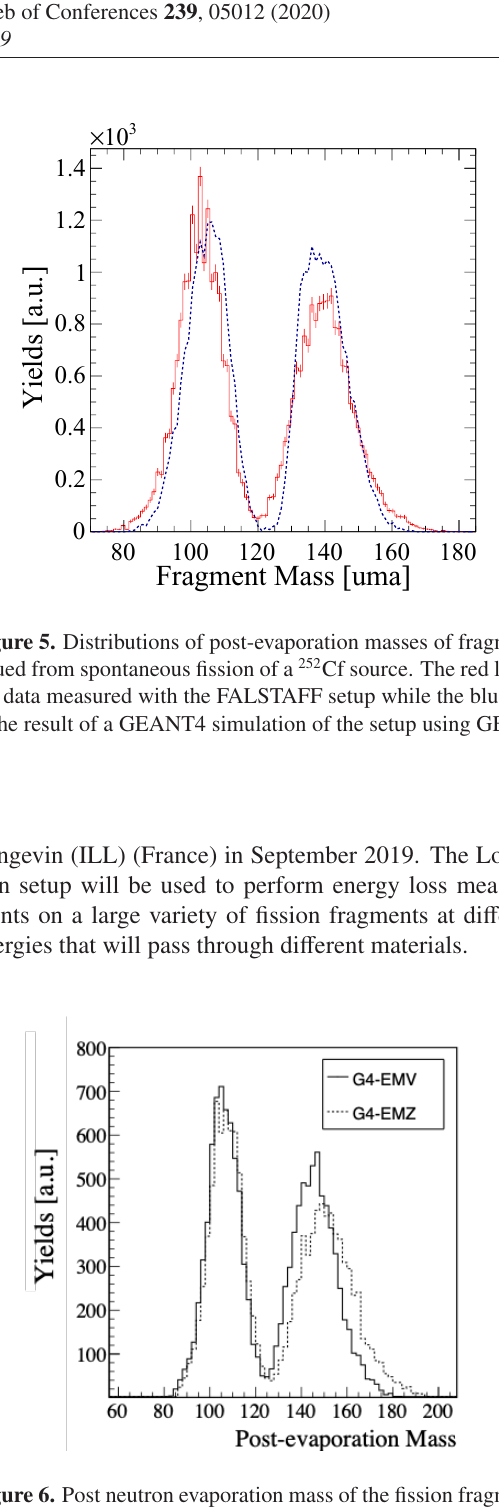
Figure 6. Post neutron evaporation mass of the fission fragments of a 252 Cf source reconstructed using two di ff erent prescription of